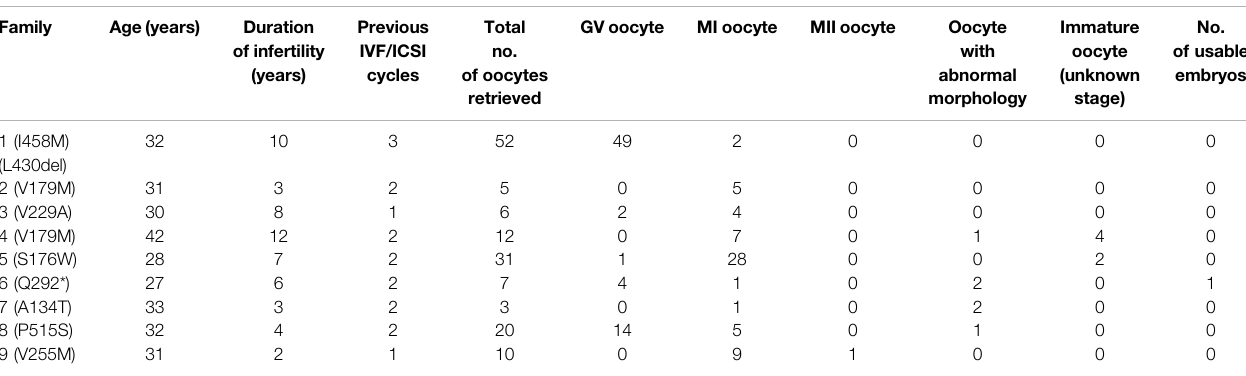
IVF, in vitro fertilization; ICSI, intracytoplasmic sperm injection; GV, germinal vesicle; MI, metaphase I; MII, metaphase II.